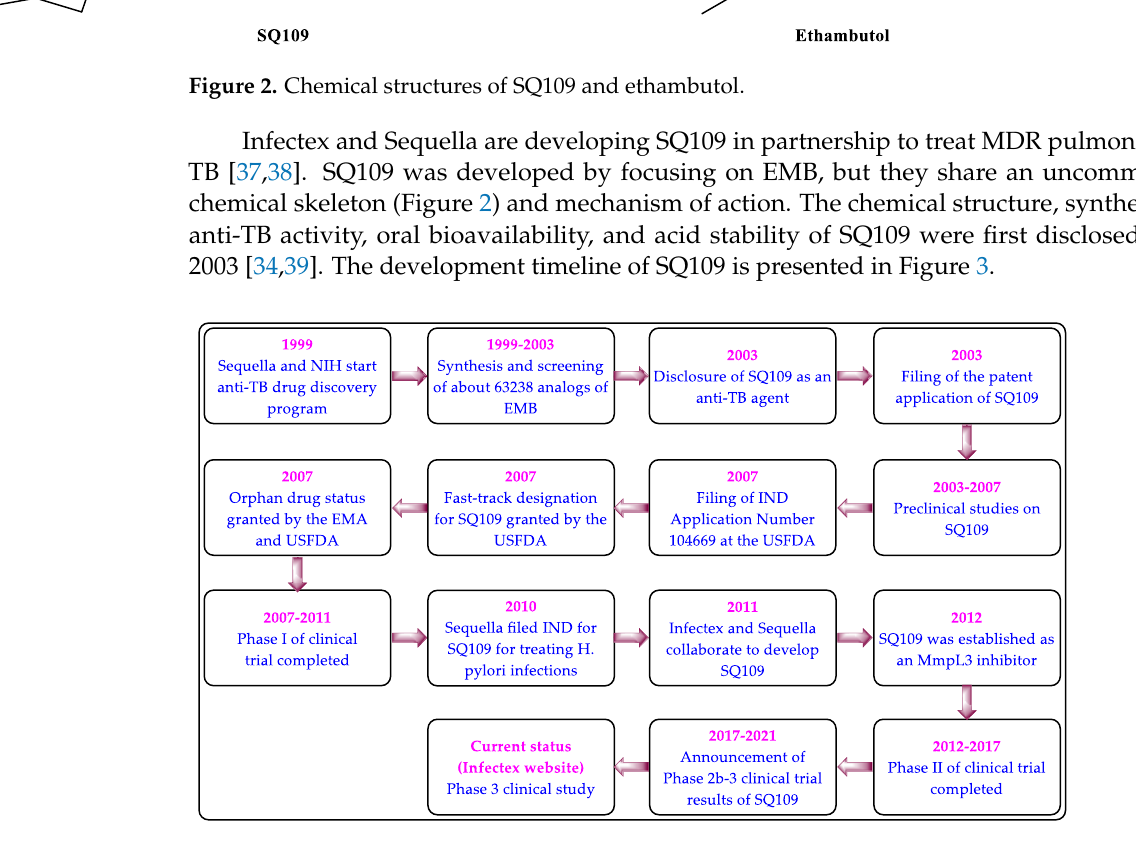
Figure 3. The development timeline of SQ109.